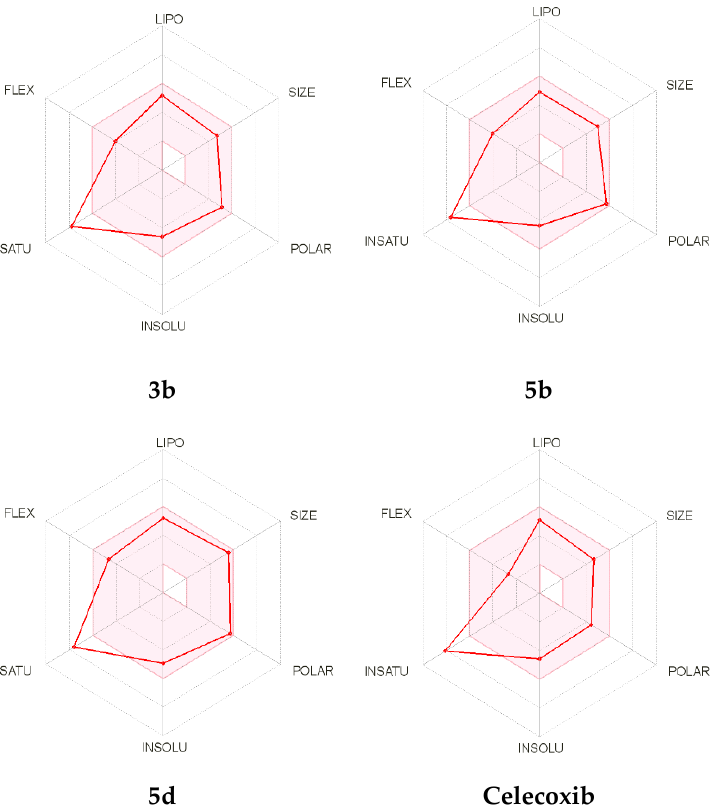
Figure 9. The bioavailability radar chart for the target compounds 3b , 5b , and 5d, as well as Celecoxib.